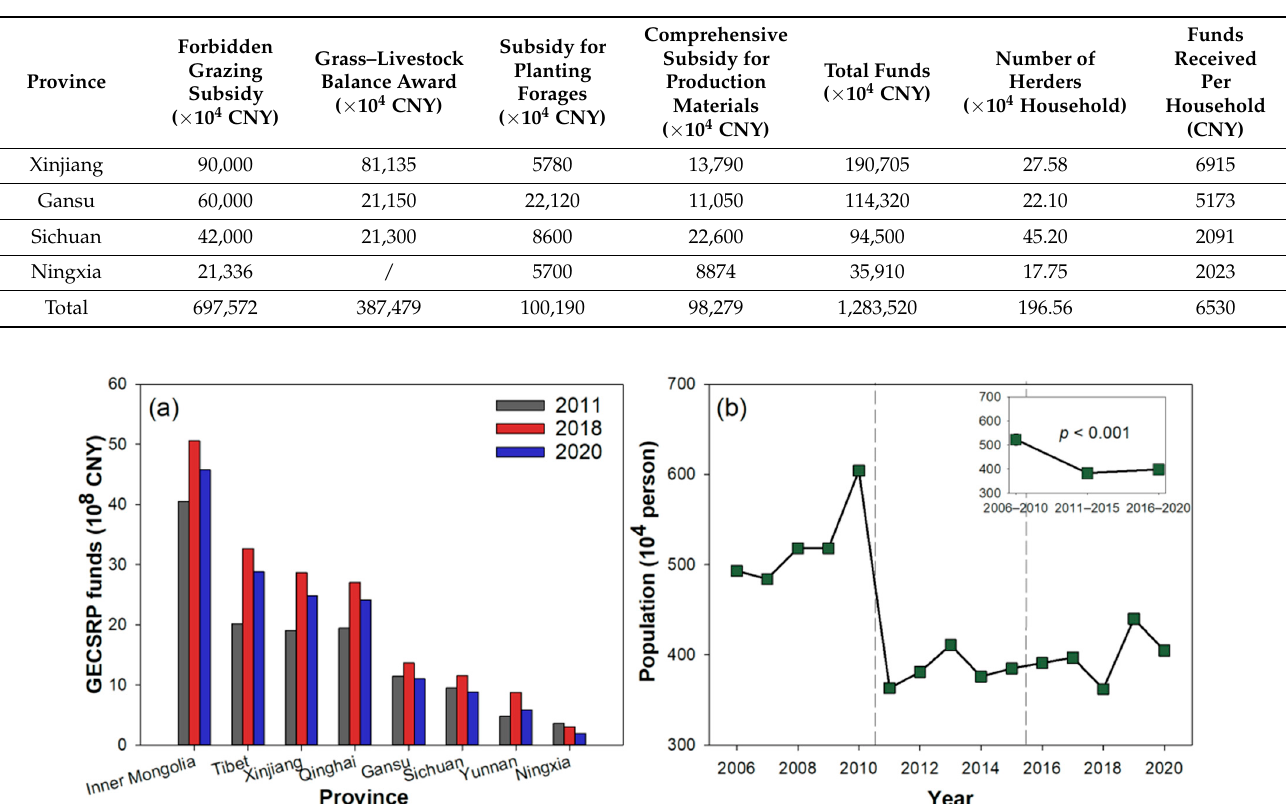
Figure 7. GECSRP funding arrangement and population changes. ( a ) The value of GECSRP funds provided to major grassland provinces in China in 2011, 2018, and 2020; ( b ) population changes in pastoral regions from 2006 to 2020.